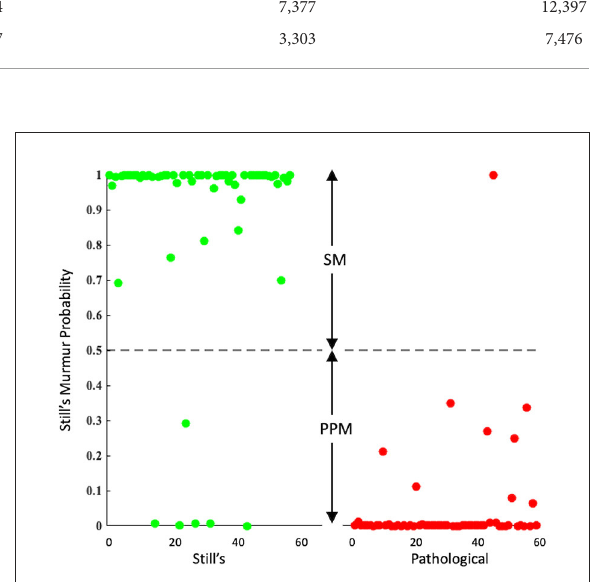
FIGURE3 Scatter plot showing the classification of known Still’s murmurs (in green) and known pathological murmurs (in red) in the test set. The algorithm classified the murmurs above the dashed line as SM and below it as